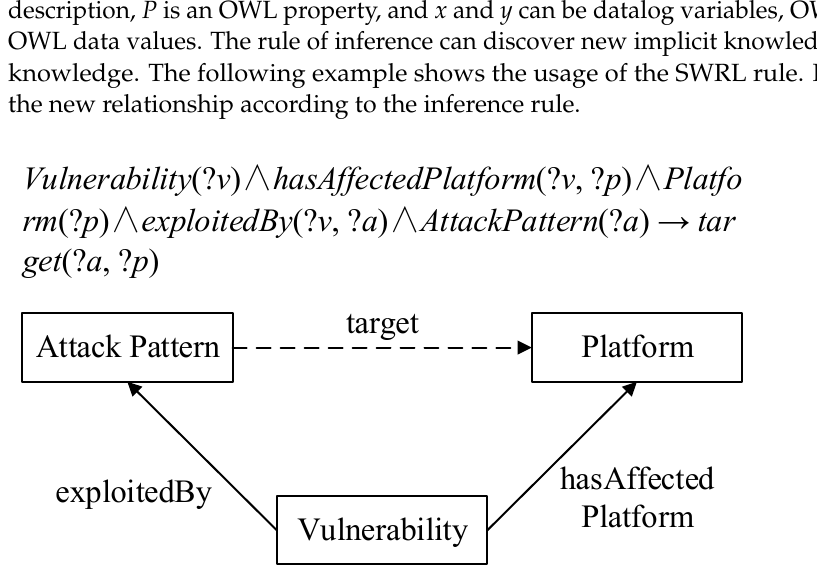
Figure 4. Examples of the SWRL inference rule and representation.